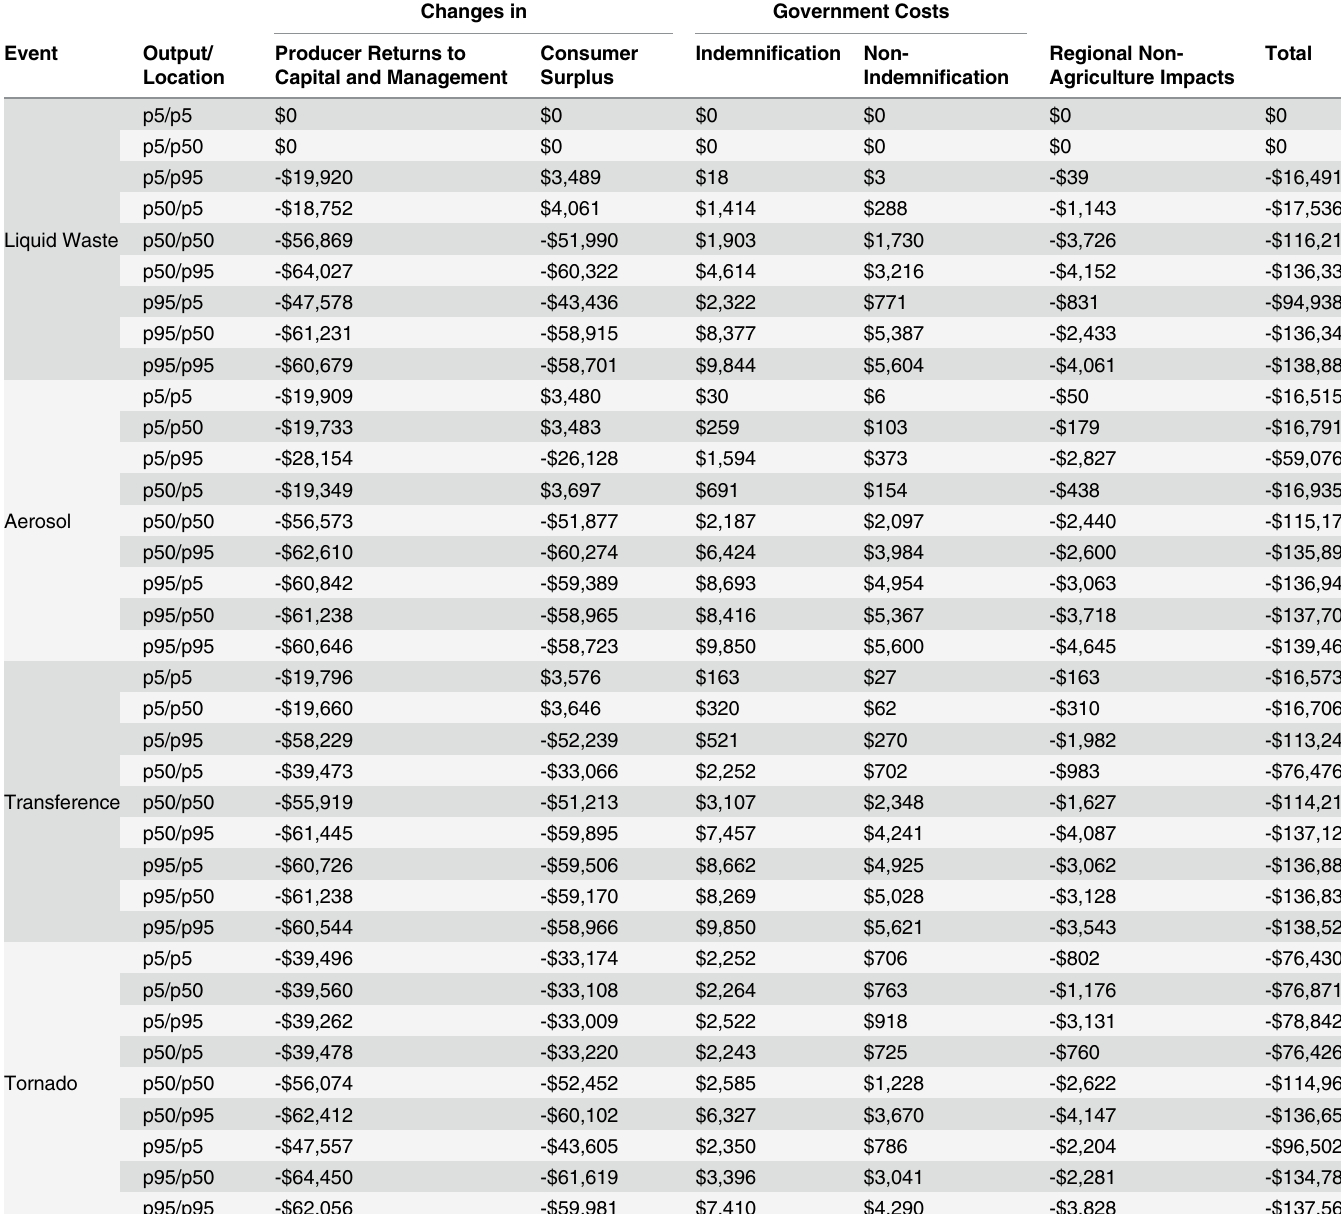
Table 6. Agricultural and Regional Non-Agricultural Impacts and Government Costs of Hypothetical FMD Outbreak (Millions